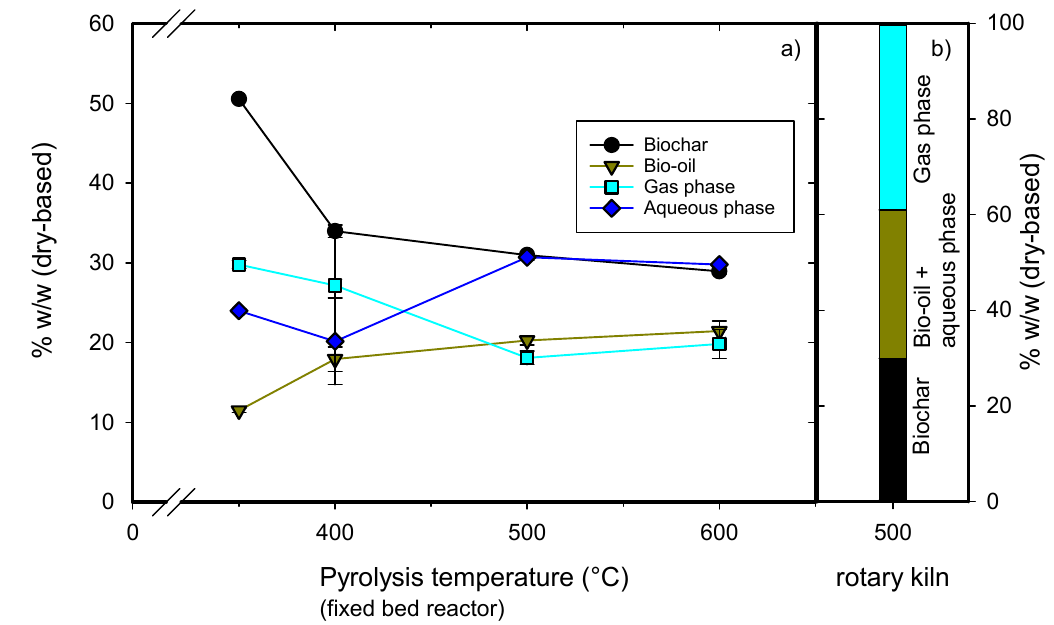
Figure 3. Effect of the process temperature on the mass fractions in ( a ) the fixed bed reactor and ( b ) the rotary kiln obtained from hazelnut shells (HNS).